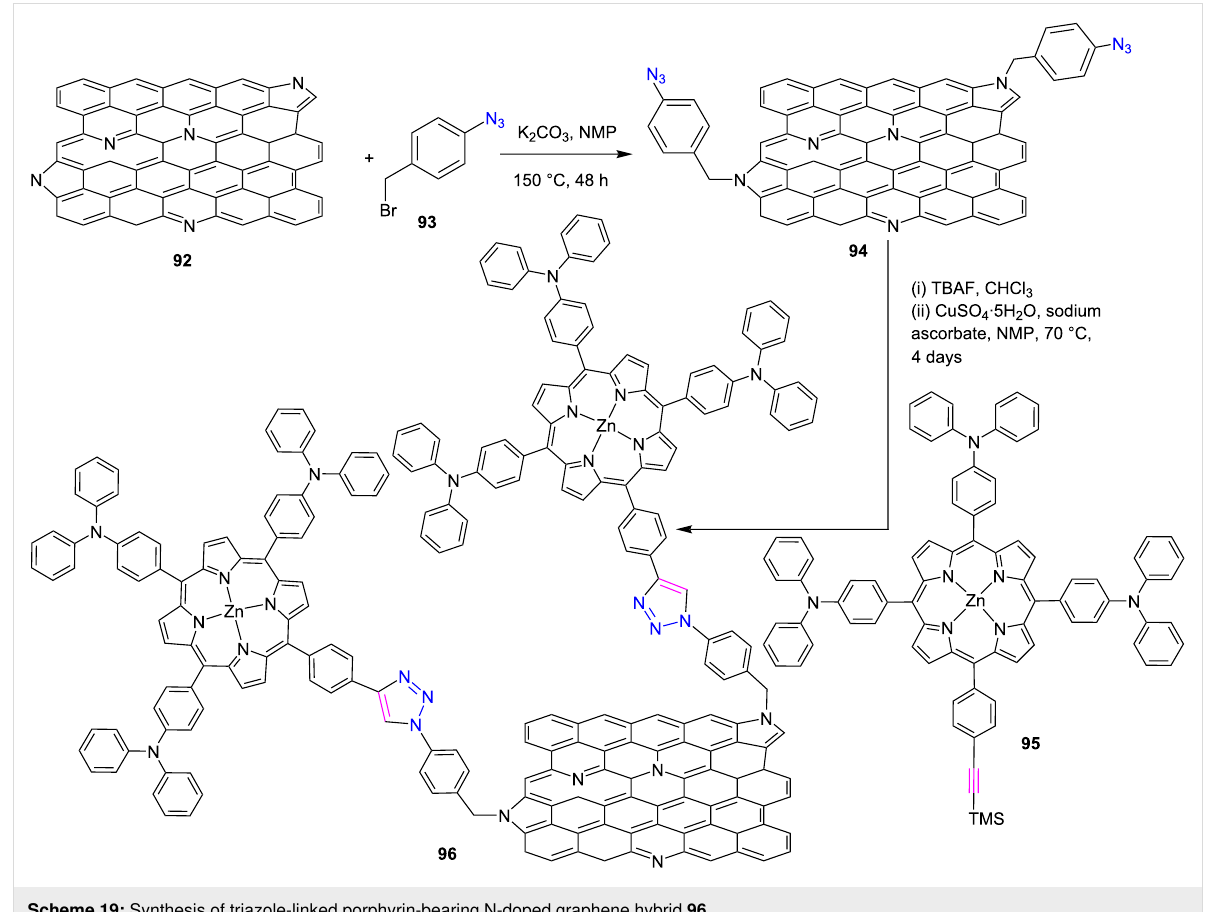
Scheme 19: Synthesis of triazole-linked porphyrin-bearing N-doped graphene hybrid 96 .